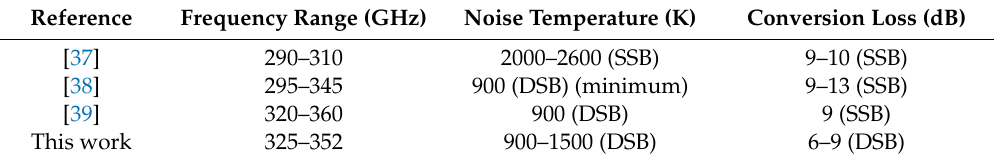
Table 3. Comparison of published Schottky SHM performance in a similar frequency range.